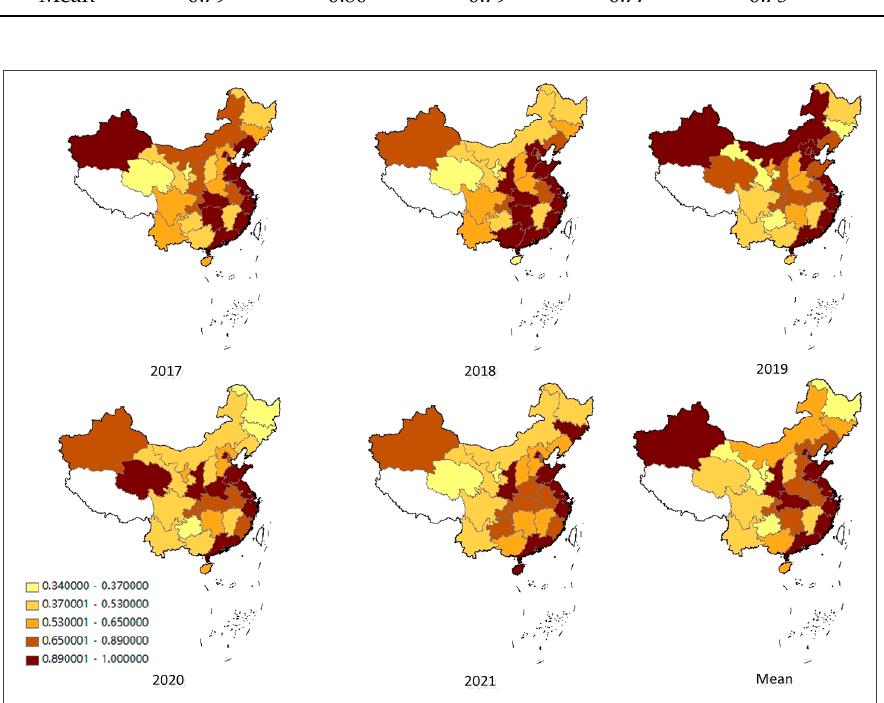
Figure 4. Scale efficiency implementation management of green buildings during